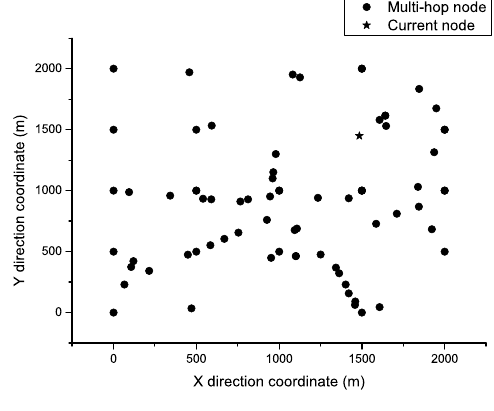
Fig.7. The locations of multi-hop nodes